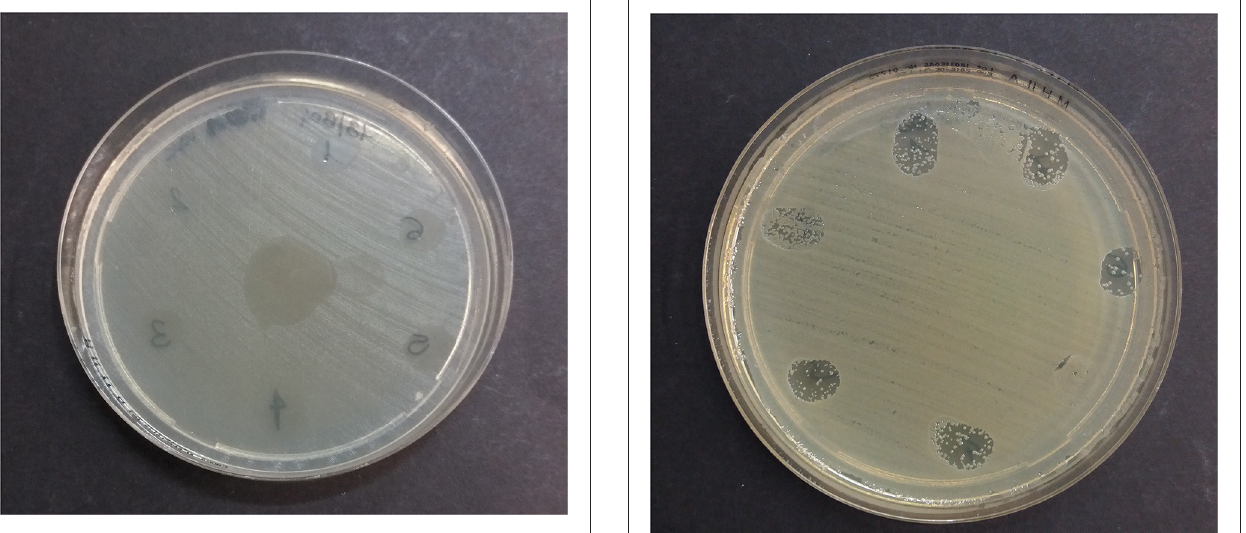
FIGURE 2 | Multidrug-resistant K. pneumoniae ssp. pneumoniae inhibition zones by leukocyte-formulations after 4h at 37 ◦ C aerobically. 1: platelet lysate; 2: thrombin; 3: L-PRP; 4: L-PRP plus thrombin; 5: L-PRP plus calcium gluconate; 6: L-PPP; in the center of the plate: L-PG.